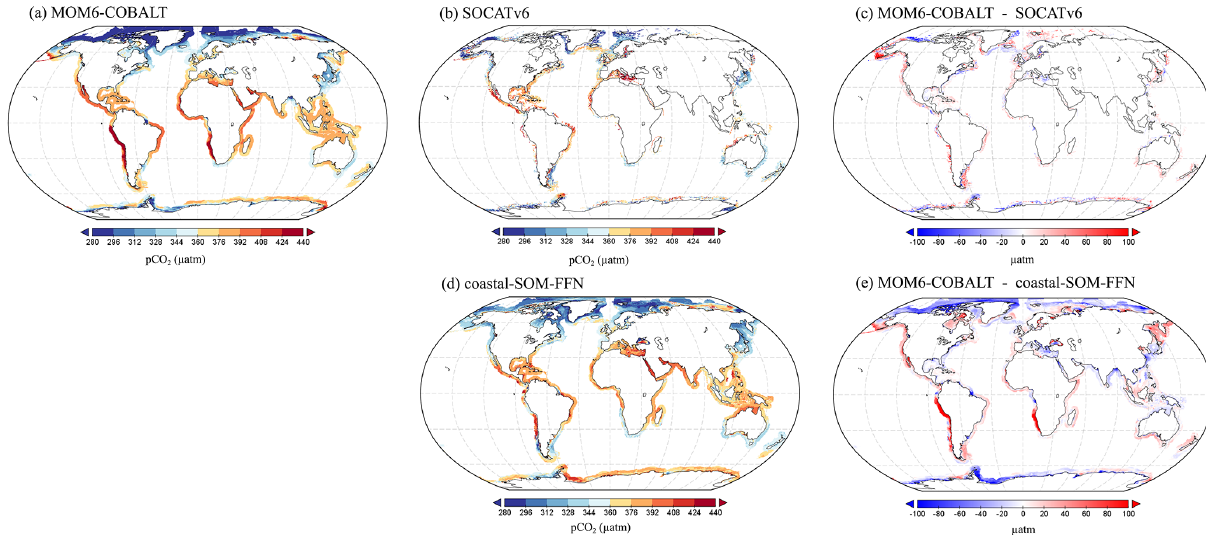
Figure 4. Spatial distributions of the annual mean p CO 2 (µatm) generated by (a) MOM6-COBALT and (b) extracted from the SOCATv6 database, (c) model bias given as the difference between panels (a) and (b) (in µatm; red and blue colors correspond to regions in which the p CO 2 simulated by MOM6-COBALT is higher and lower than SOCATv6, respectively). (d) Spatial distribution of the annual mean p CO 2 from the coastal SOM-FFN product (Laruelle et al., 2017). (e) Model bias given as the difference between panels (a) and (d) .